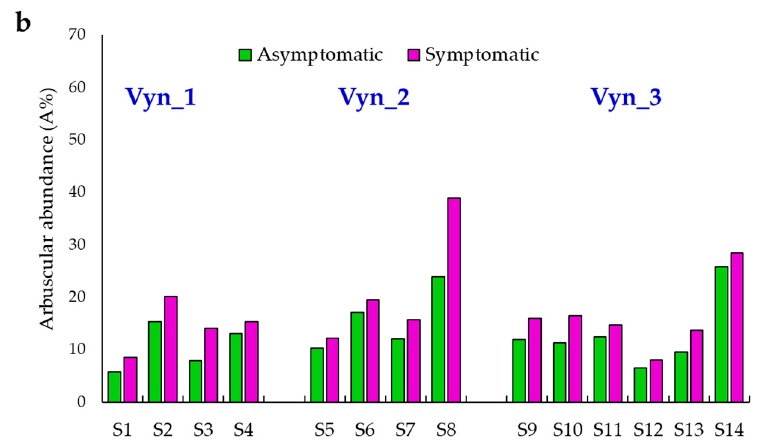
Figure 1. AMF mycelium colonization (M%), ( a ), and arbuscular abundance (A%) ( b ), detected by non-vital staining from each asymptomatic and contiguous esca symptomatic plants from each site (S) individuate in the vineyards (Vyn_1, Vyn_2 and Vyn_3). Positive correlation among esca symptomatic and asymptomatic plants of both AMF mycelium colonization (Figure 2a) and arbuscular abundance was detected (Figure 2b).